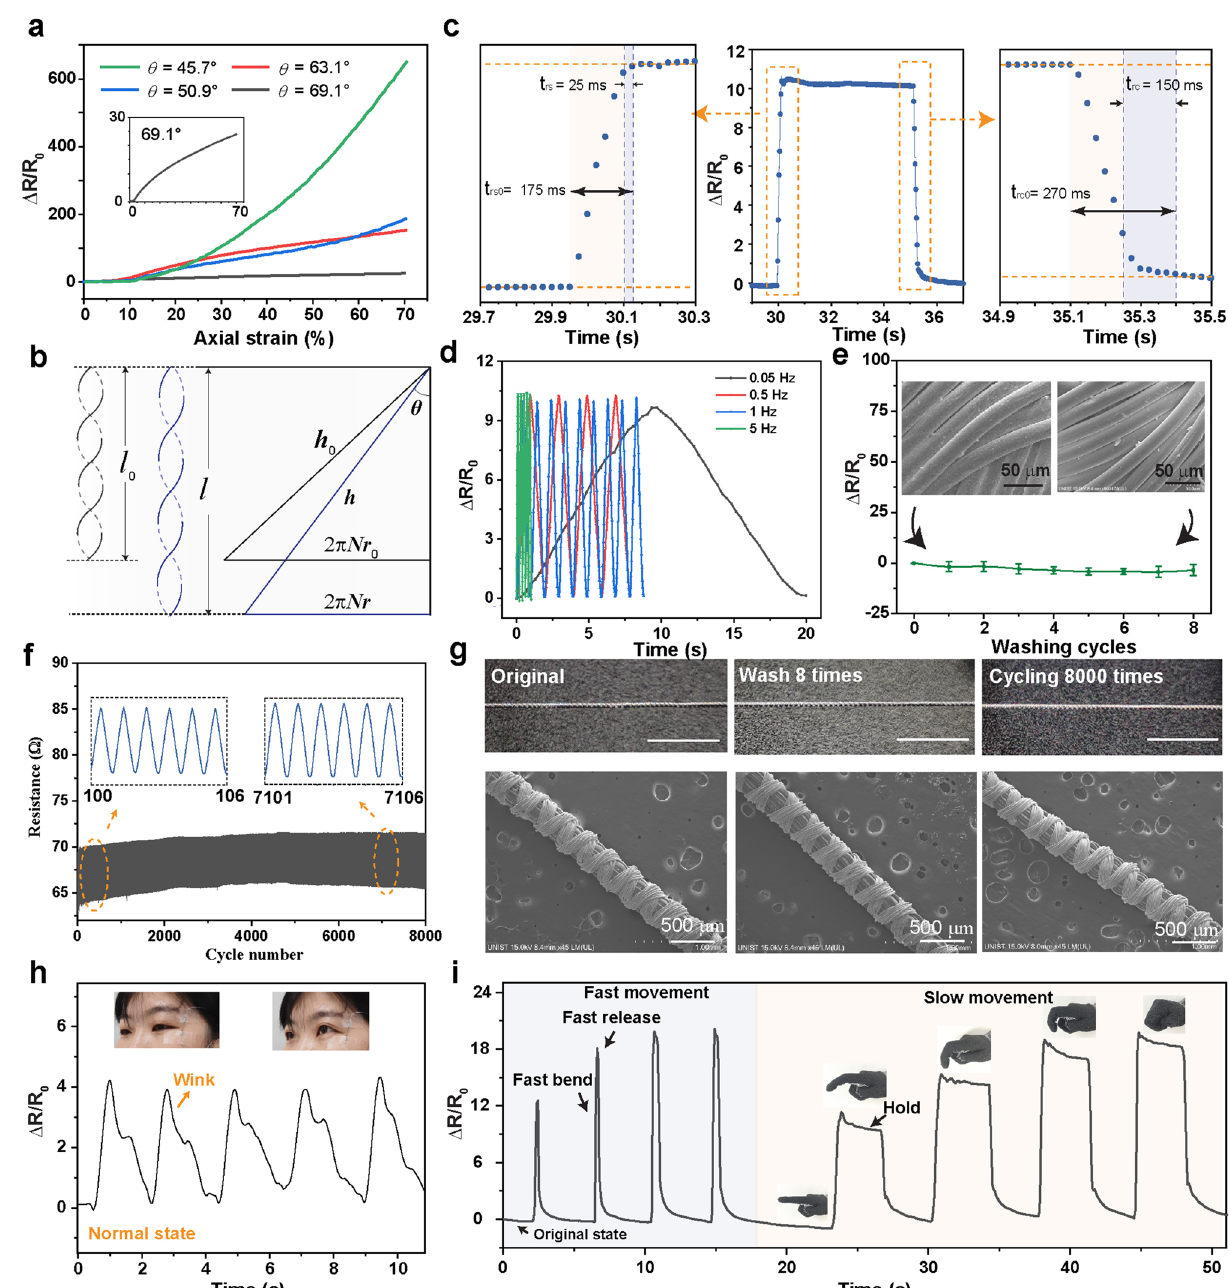
Fig. 3 Sensing performance of the AIYS sensing. a Relative change in resistance (Δ R / R 0 ) of AIYS during stretching. b Response and recovery time ( t rs and t rc ) of the AIYS sensor when stretched to 15% strain. c Illustration of the unfolding of the spiral sheath yarn. d Response of AIYS under the frequency range of 0.05–5 Hz. e Resistance variation of the AIYS after continuous washing test. Insets depict the SEM images of the conductive part of AIYS, showing no obvious change. f Cyclic electrical performance of AIYS sensor for stretching and recovery 8000 times; insets depict the amplification of the signal near the beginning (Cycle No. 100–106) and the end of the test (Cycle No. 7101–7106). g Optical and SEM images of the AIYS in the states of origin with washing 8 times and cycling 8,000 times. Scale bar of 50 mm. h Detected signals of human winking when volunteers wear the AIYS at the eye corner, the insets are the pictures showing the upper facial expressions around the eyes. i Real-time sensing performance of the AIYS-embedded glove after fast bending, slow bending, keeping, and releasing